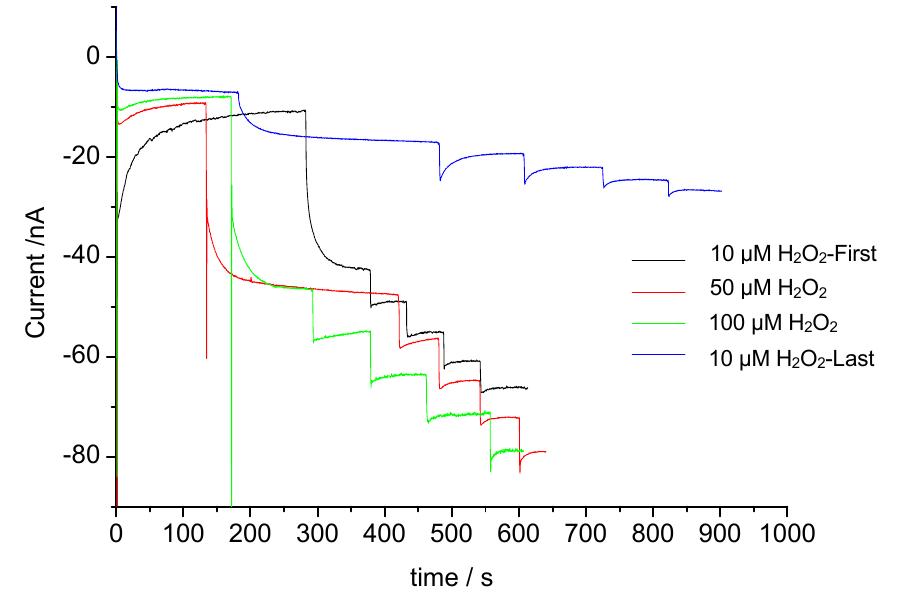
Figure 8. Amperometric responses of MP-11-AuNP-CH/GCE on stepwise addition of pAP in presence of different peroxide